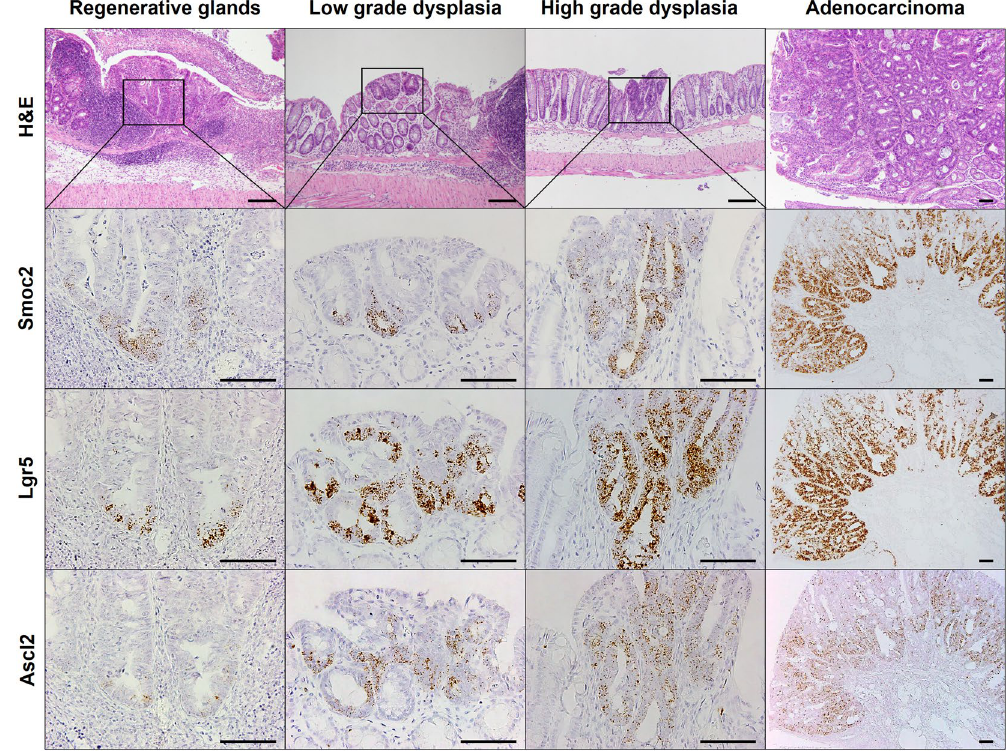
Figure 5. RNA in situ hybridization for crypt base columnar (CBC) stem cell markers in colitis-associated dysplasia and cancer. Representative hematoxylin and eosin-stained images of regenerative glands, low grade dysplasia, high grade dysplasia, and adenocarcinoma. RNA in situ hybridization (ISH) demonstrates the expression of Smoc2, Lgr5, and Ascl2 in each lesion. Scale bars: 50 μ